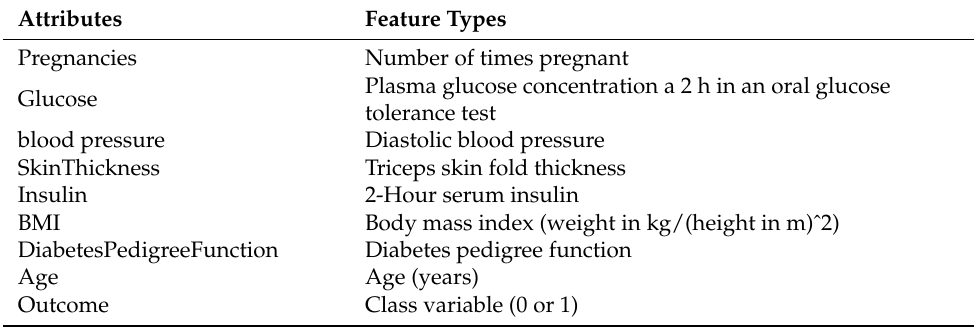
Table 3. Attributes and their feature types.